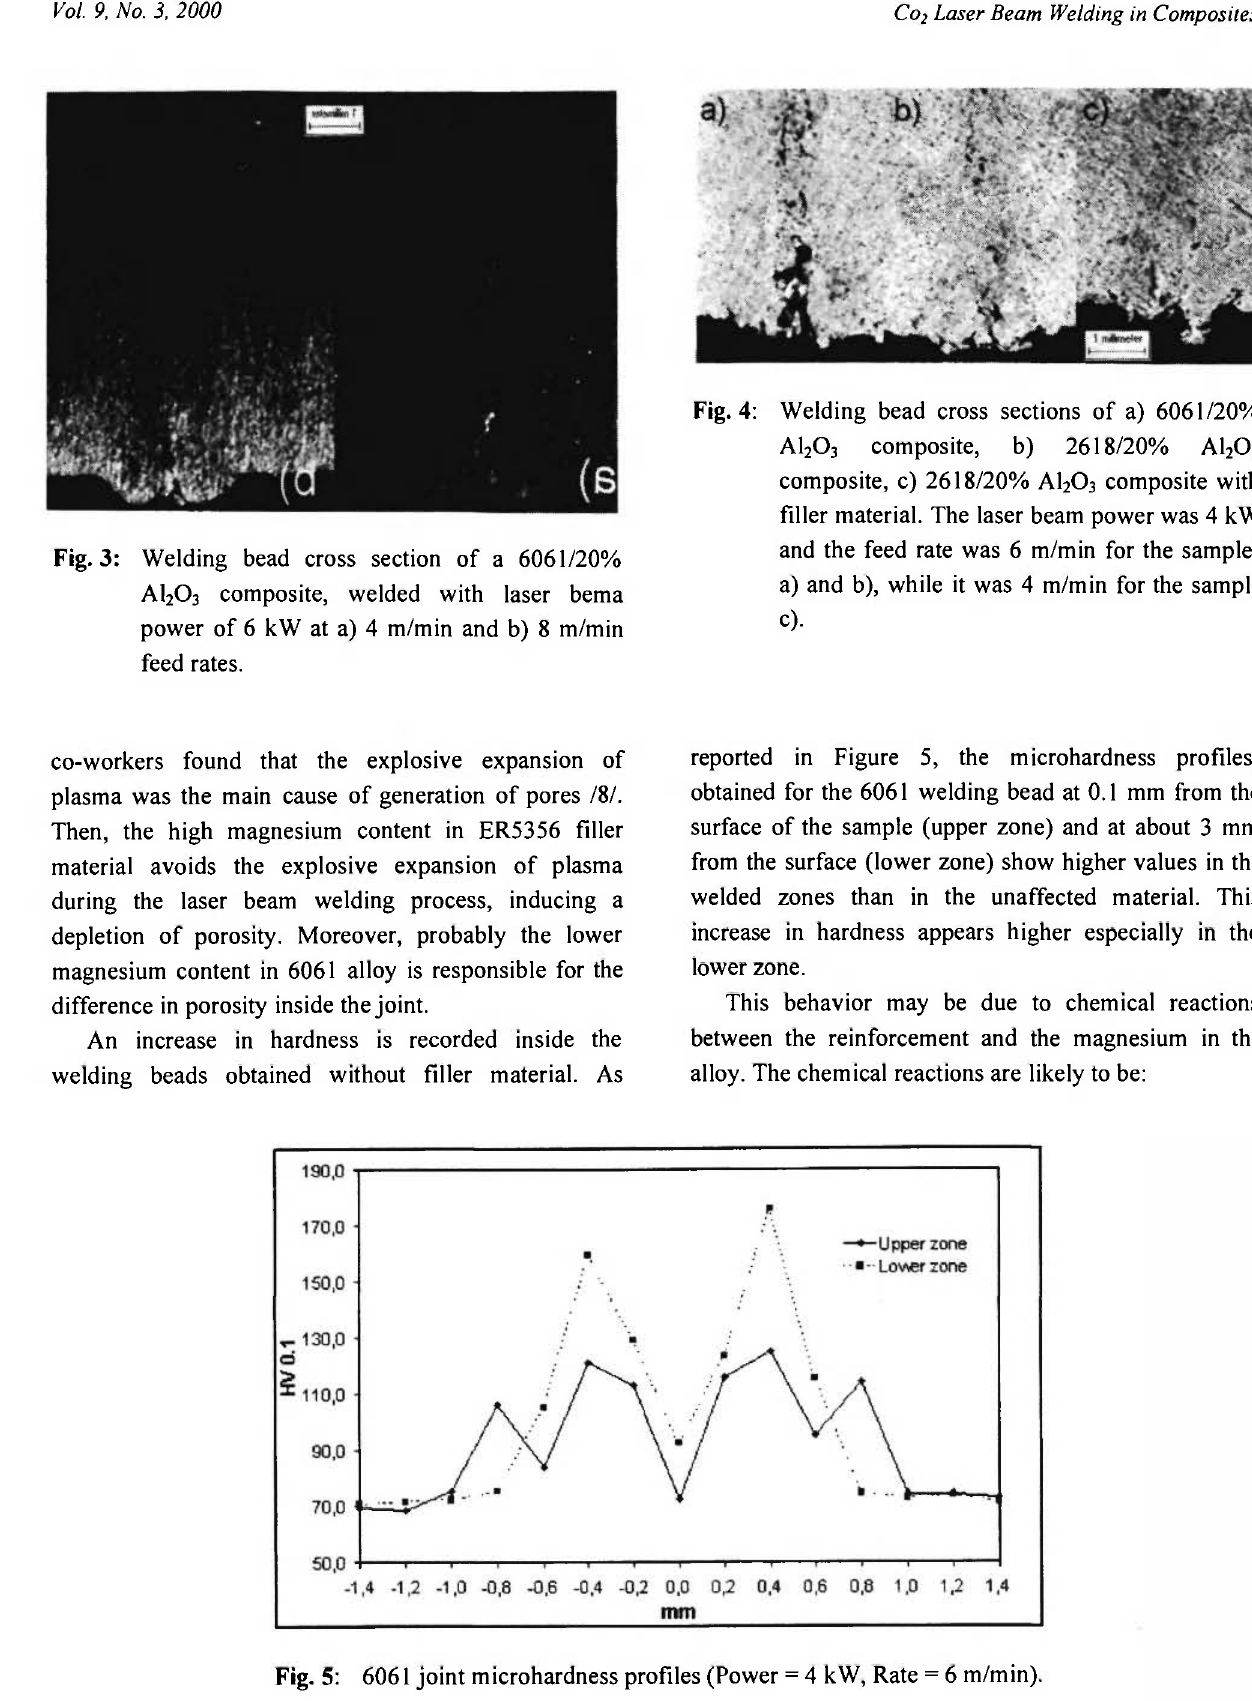
Fig. 5: 6061 joint microhardness profiles (Power = 4 kW, Rate = 6